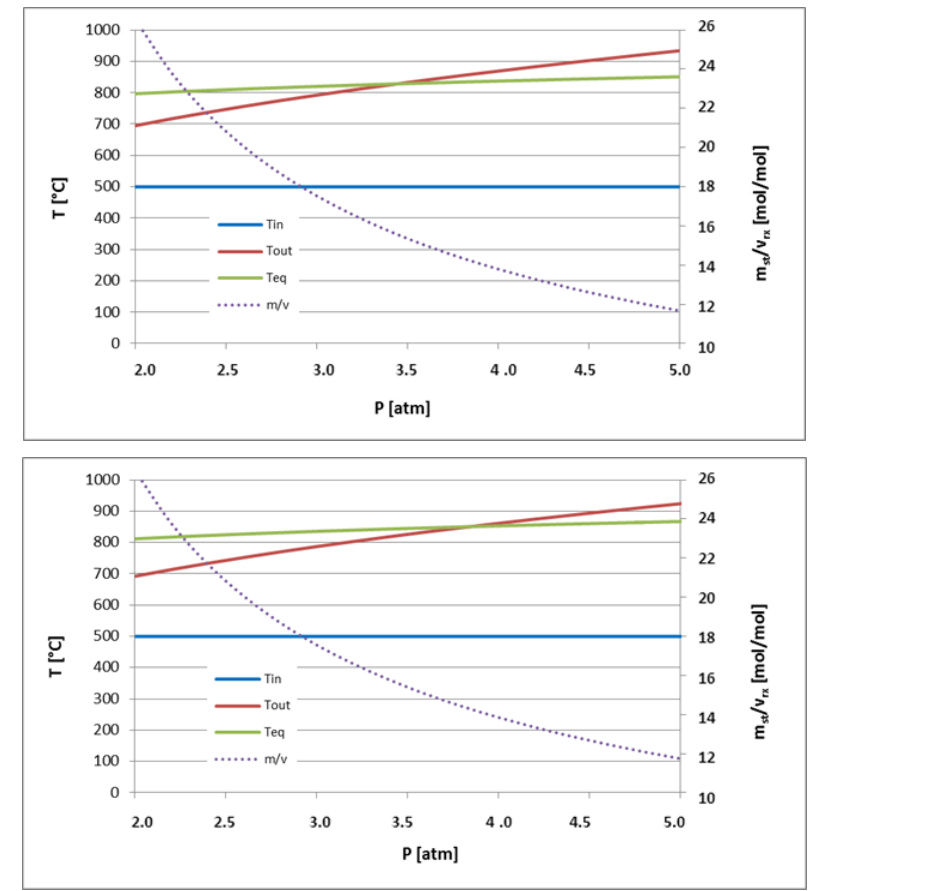
Figure 19. CaCO 3– CaO reactor (discharging step and open loop): parametric analysis of the inlet and outlet temperature and equilibrium temperature varying the inlet total pressure (power block outlet